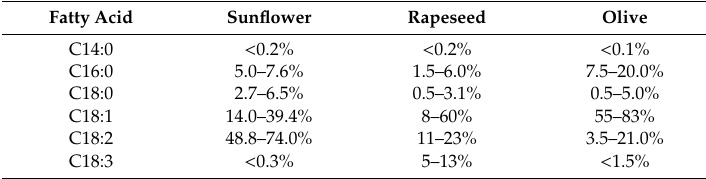
Table 2. Fatty acid profiles of potential adulterants. The numbers are from the Codex Alimentarius 2001 of the Food and Agricultural Organization of the United Nations World Health Organization [39]. Fatty Acid